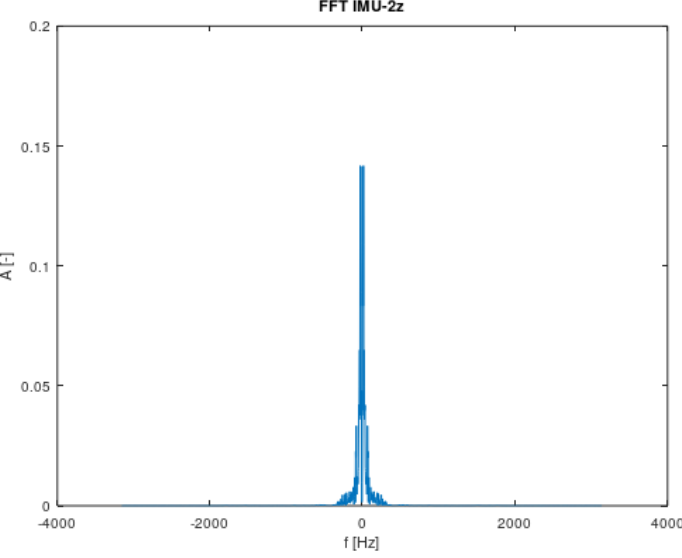
Figure 10. Fast Fourier Transform for IMU-2z.